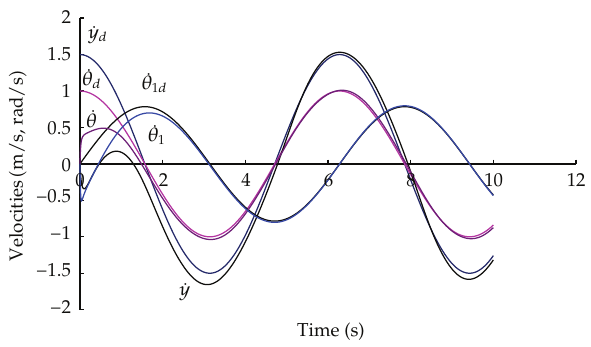
Figure 2: The positions of the joints.